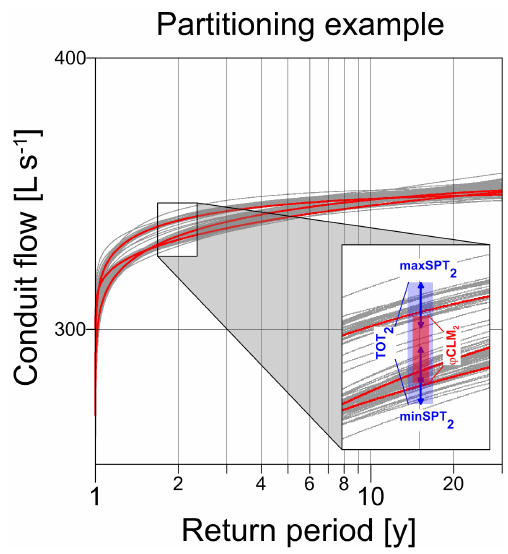
Figure 5. An example of the partition method (illustrative) for the 2-year return period (zoomed panel). Three climate trajectories are plotted (red lines) for which the 5–95 quantile range is calculated ( ϕ CLM , 2 , red area). For each climate trajectory, 30 spatial realiza- tions are plotted (gray lines). The 5–95 quantile range is then cal- culated for each of the 30 spatial realizations (SPT 1 plotted as blue arrows) and the total variability, TOT 2 (blue area), is defined by bounding the maximum and minimum flows defined by the spatial variability (max SPT 2 and min SPT 2 , respectively). The partition of the climate variability, ϕ CLM , 2 , out of the total variabil- ity is then calculated as a simple ratio between the